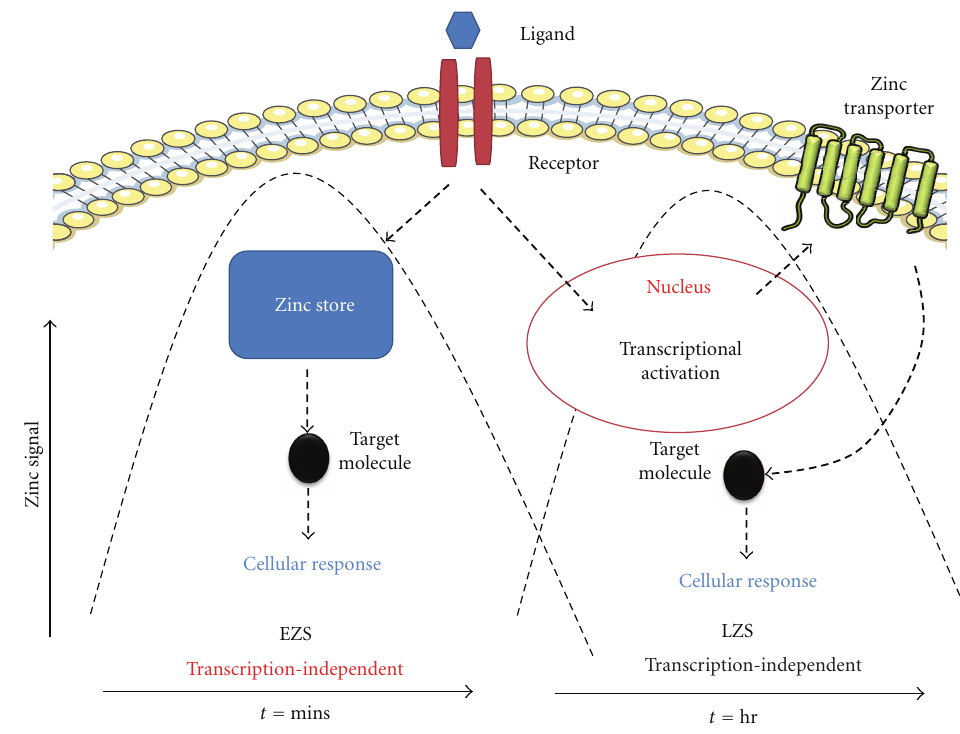
Figure 2: Early zinc signaling (EZS) and late zinc signaling (LZS) . EZS involves transcription-independent mechanisms where an extracellular stimulus directly induces an increase in zinc levels within several minutes by releasing zinc from intracellular stores (e.g., endoplasmic reticulum). LSZ is induced several hours after an external stimulus and is dependent on transcriptional changes in zinc transporter expression. Components of this figure were produced using Servier Medical Art, http://www.servier.com/ and adapted from Fukada et al.